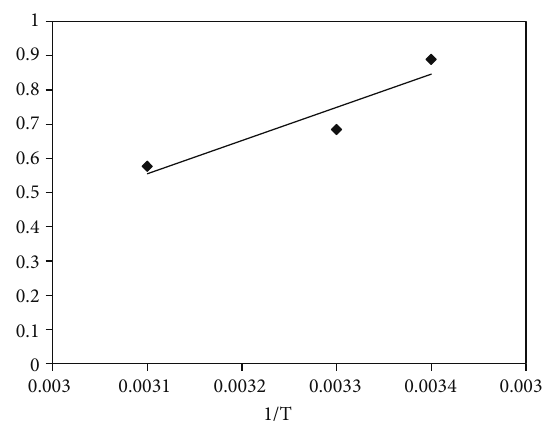
Figure 9: Thermodynamic plot of Neolamarckia cadamba for the adsorption of methylene blue. Table 6: Thermodynamic parameters for the removal of methylene blue on Neolamarckia cadamba leaves.